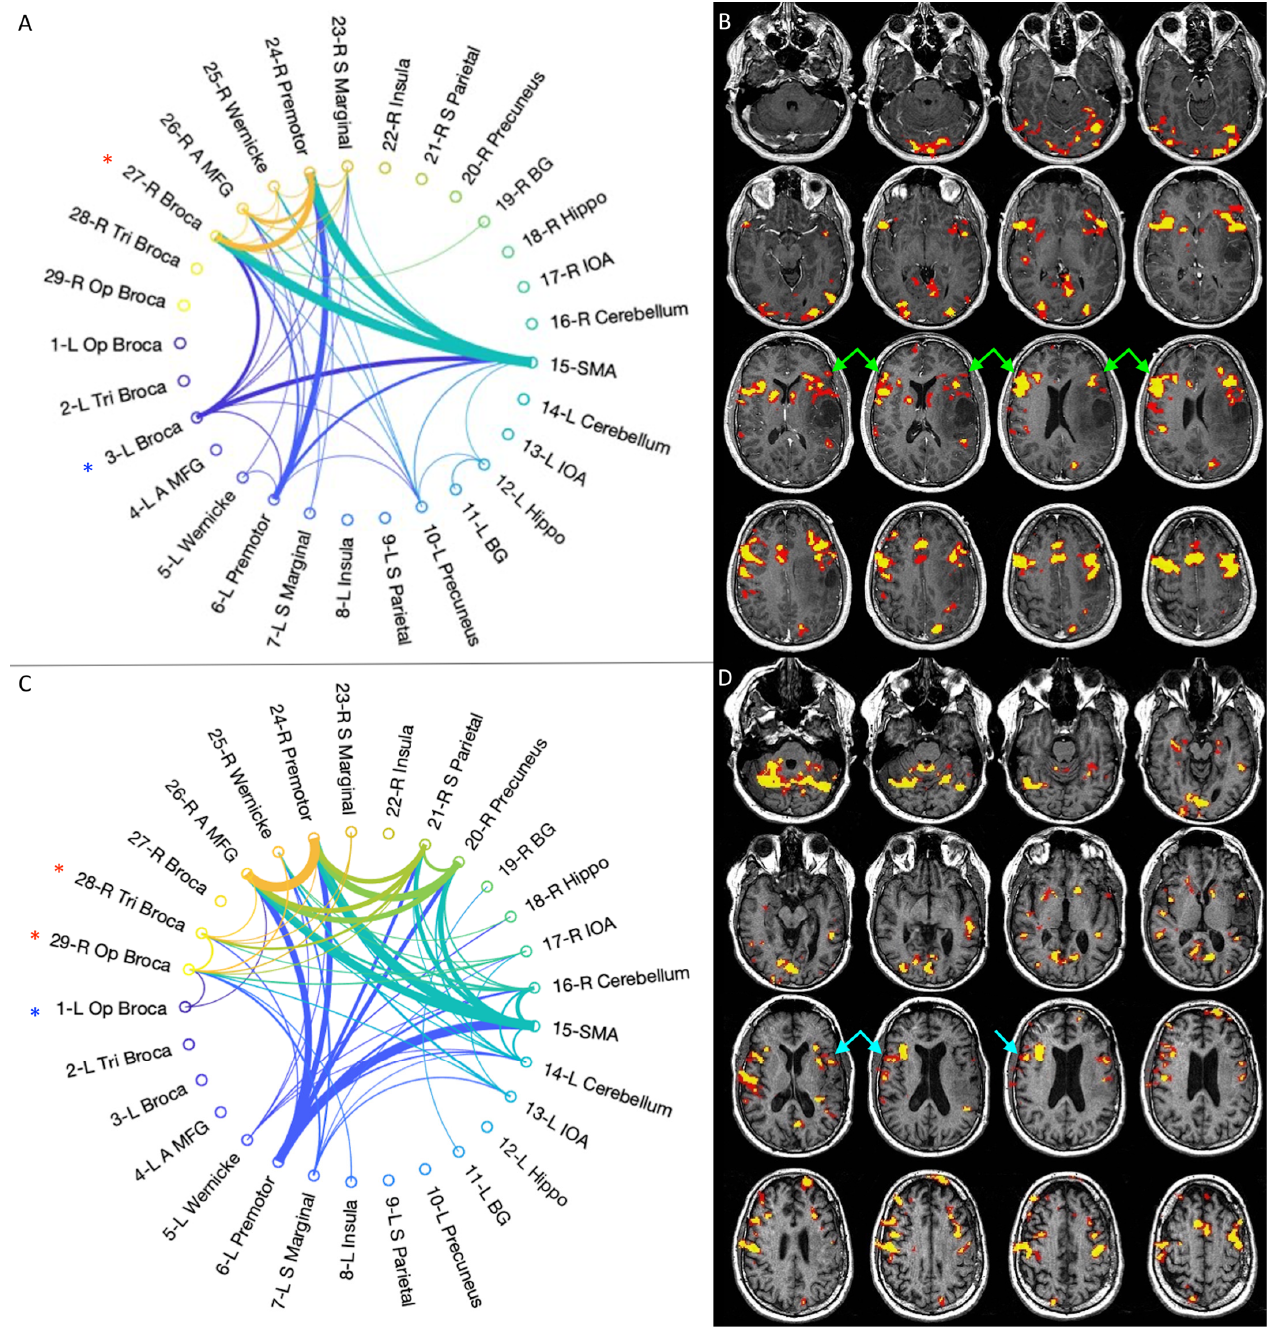
Figure 3. Representative case for type 2 language reorganization. The images on top show the connectivity diagram ( A ) and fMRI activation map obtained with letter task ( B ) at the first timepoint (pre-op). The patient was right-dominant on the preoperative fMRI, with right-greater-than-left activation of Broca’s area (green arrows in ( B )). The connectivity diagram mirrors these findings, showing stronger connectivity in right Broca’s area homologous (red asterisk in ( A )) than in left Broca’s area (blue asterisk in ( A )). The images at the bottom show the connectivity diagram ( C ) and fMRI activation map obtained with letter task ( D ) at the last timepoint (post-op3). The patient remained right-dominant on fMRI (light blue arrows in ( D )). The connectivity diagram shows increased inter-hemispheric and right-side connections, with persistent stronger connectivity in right Broca’s area homologous (red asterisks in ( C )) than in left Broca’s area (blue asterisk in ( C )). This type of reorganization was found in case 2,